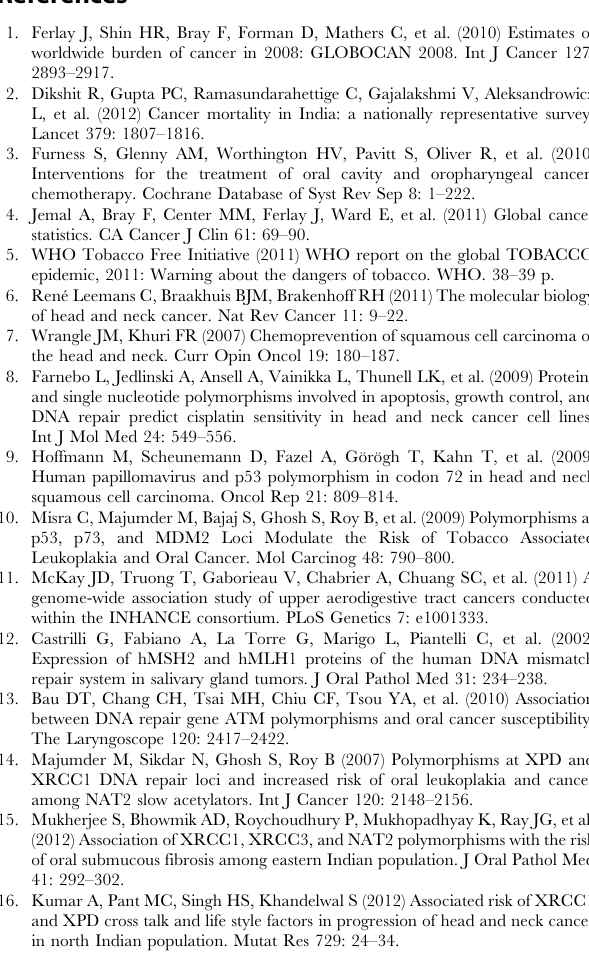
Table S5 MDR interaction analysis between SNPs and lifestyle factors.